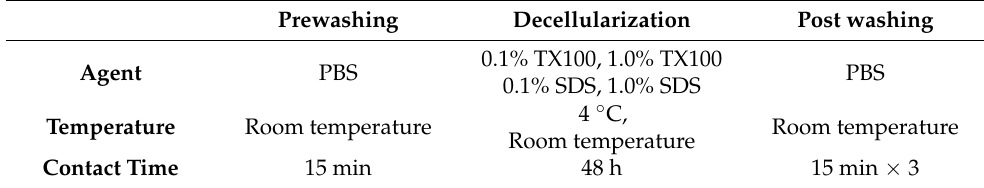
Table 1. Overview of the decellularization